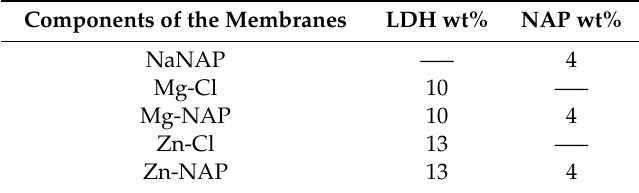
Table 1. Weight percentages of LDH and NAP in the membranes. Components of the